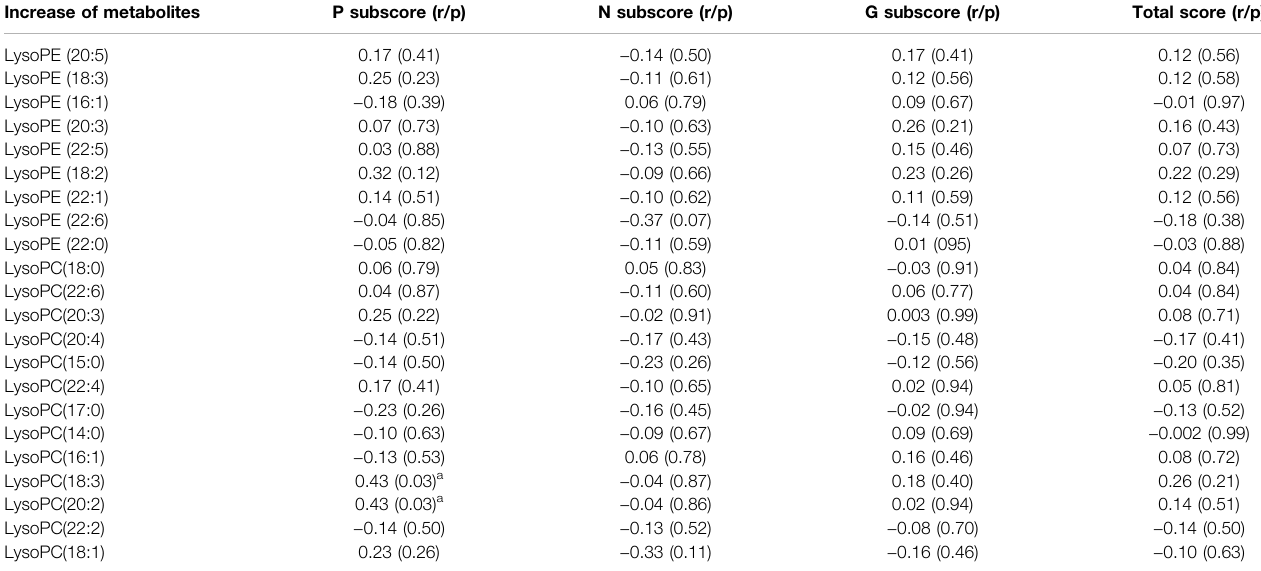
TABLE 3 | The correlation between the increase of metabolite levels and the reduction of clinical symptoms. Increase of metabolites P subscore (r/p)